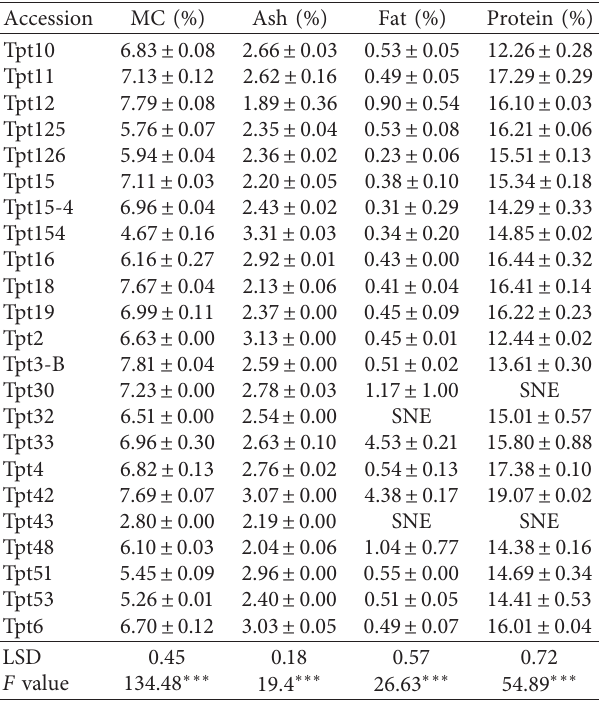
Table 6: Percentage nutrient (mean ± standard deviation) of flours from winged bean